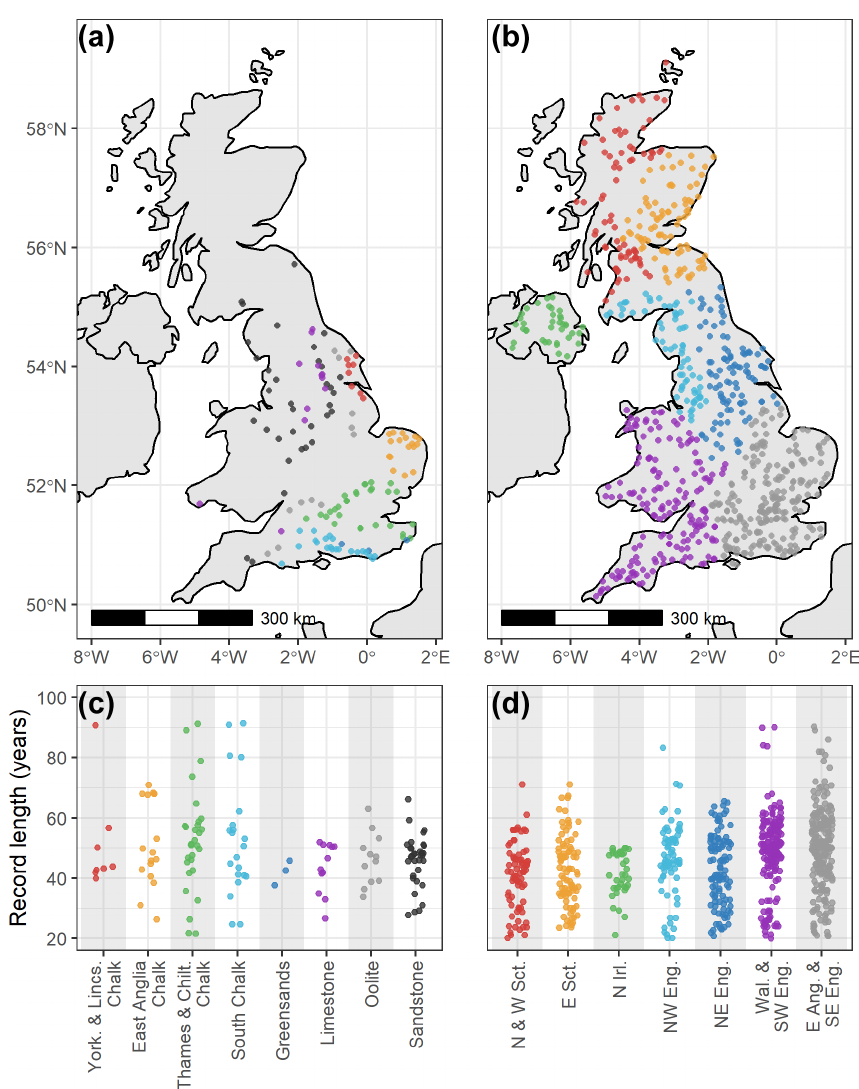
Figure 1. Spatial and temporal distributions of water resource records: (a) location of groundwater boreholes coloured by associated aquifer group; (b) jitter plot of groundwater record lengths within each aquifer group; (c) location of streamflow gauges coloured by associated regional group; and (d) jitter plot of streamflow record lengths within each regional